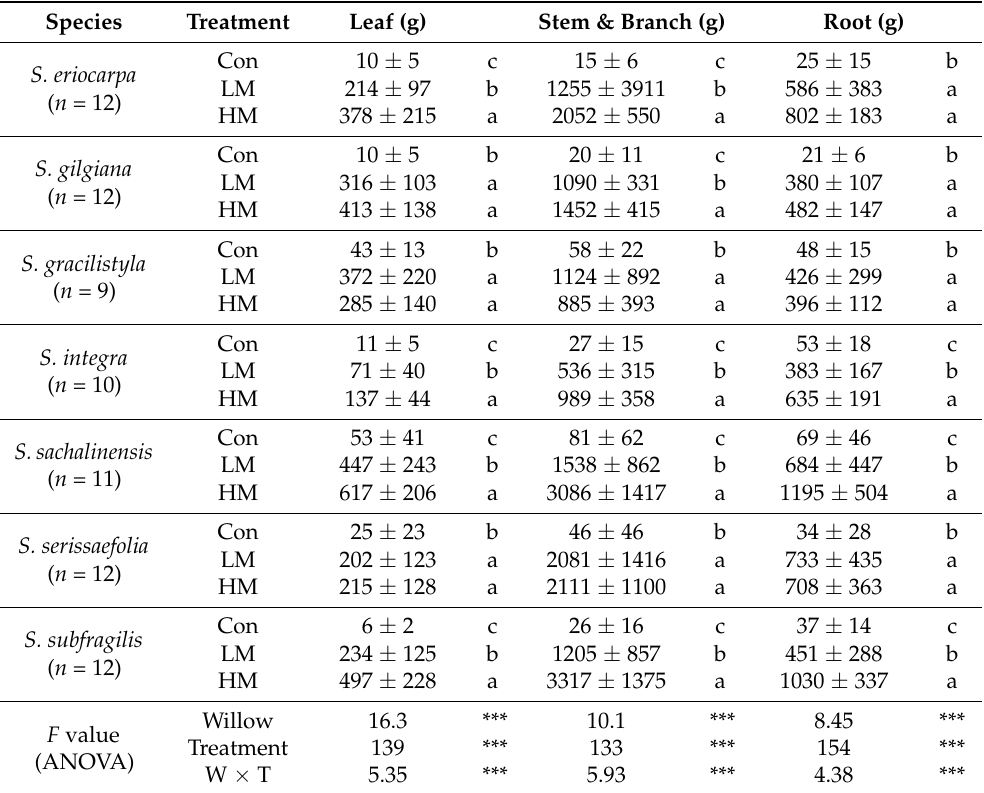
Table 5. Dry mass in different tissues of individuals of the seven willows grown under three treatments (mean ± SD). Asterisks indicate significant differences among seven willows, three treatments, and their interaction (W × T) calculated by ANOVA (*** = p < 0.001). Species Treatment Leaf (g) Stem & Branch (g) Root